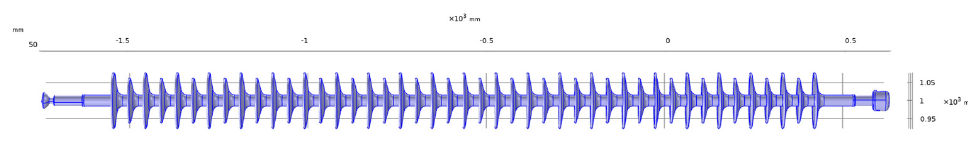
Figure 2. Full-size composite insulator model.